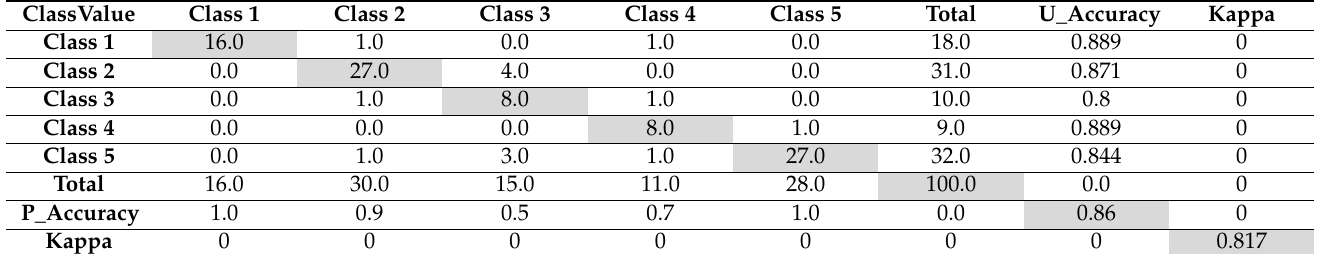
Table 2. The confusion matrix showing the accuracy assessment of the classified